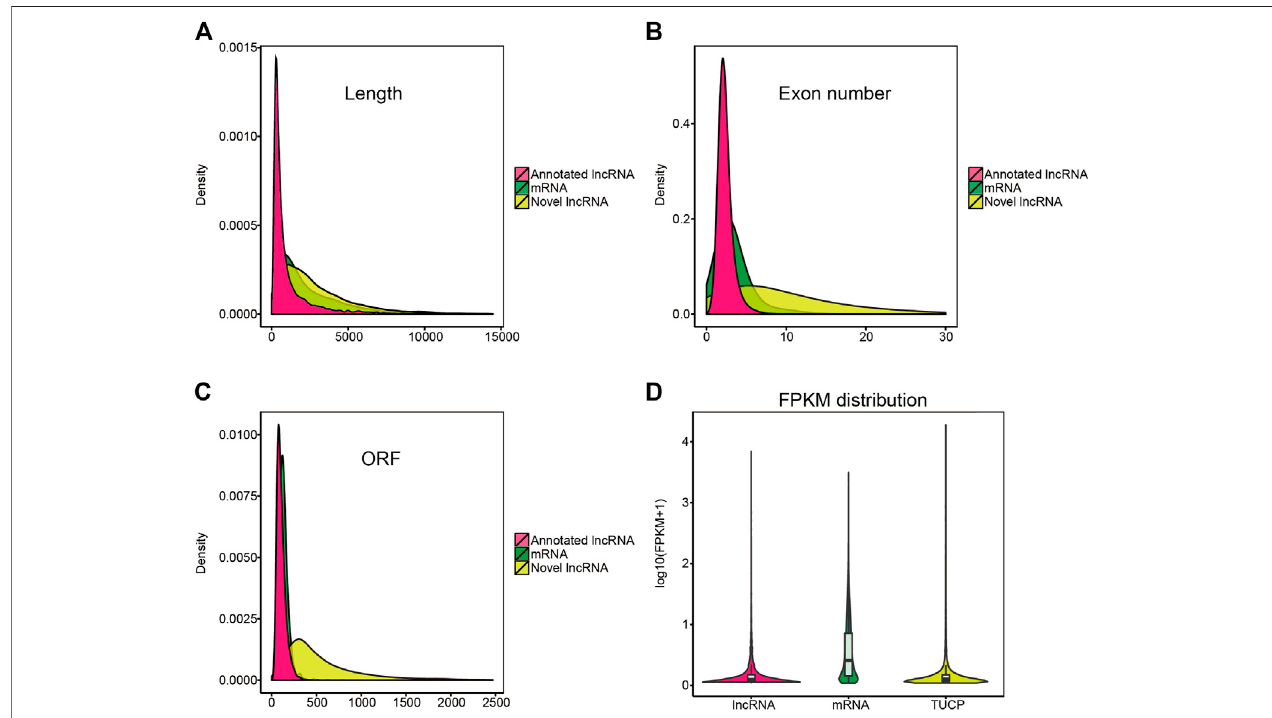
FIGURE 4 | Characterization of candidate lncRNA and mRNA. (A – C) Length, exon number, open reading frame (ORF) length distribution of mRNA, annotated lncRNA, and novel lncRNA. (D) violin plot of expression level about mRNAs, annotated-lncRNAs, and novel-lncRNAs.